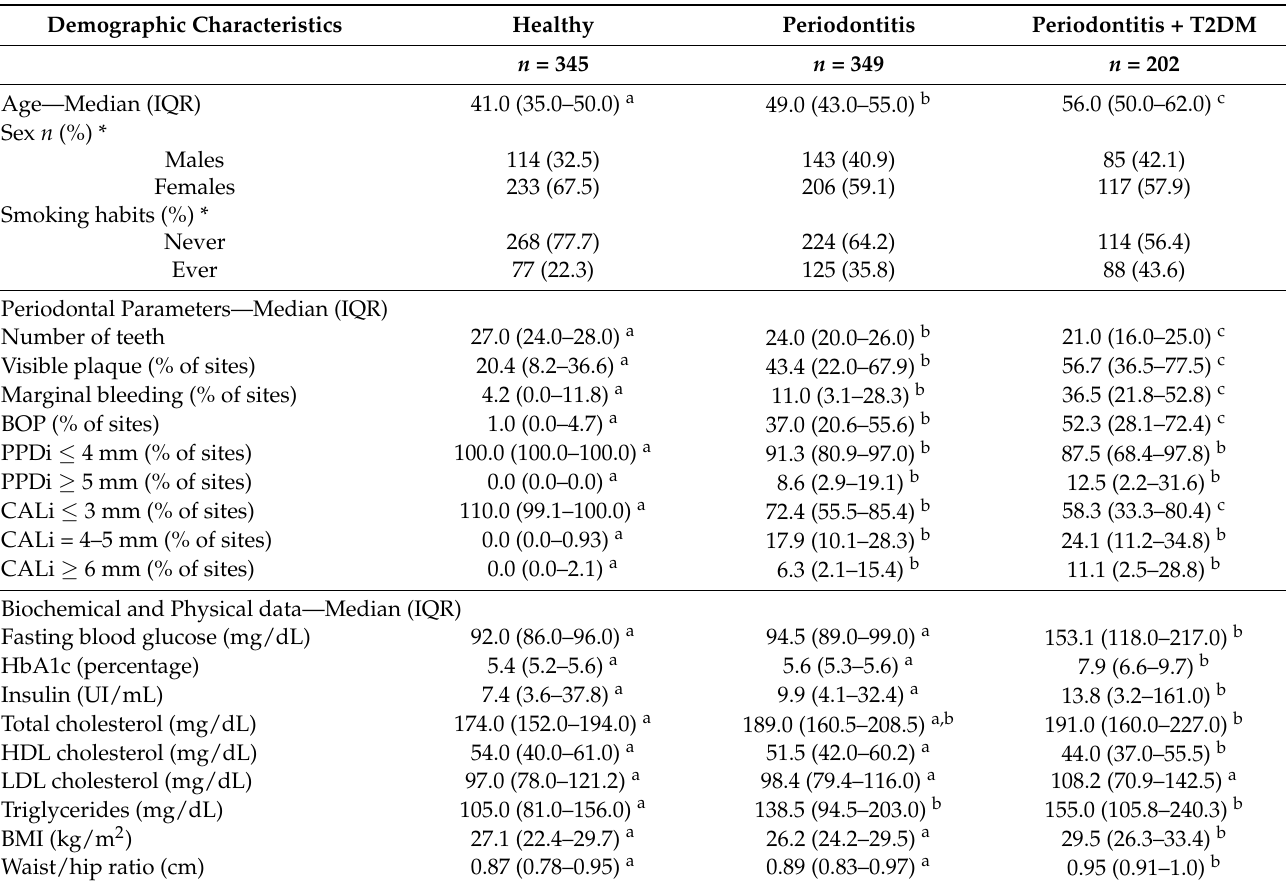
Table 1. Comparison of demographic characteristics, and periodontal, biochemical, and physical parameters among the